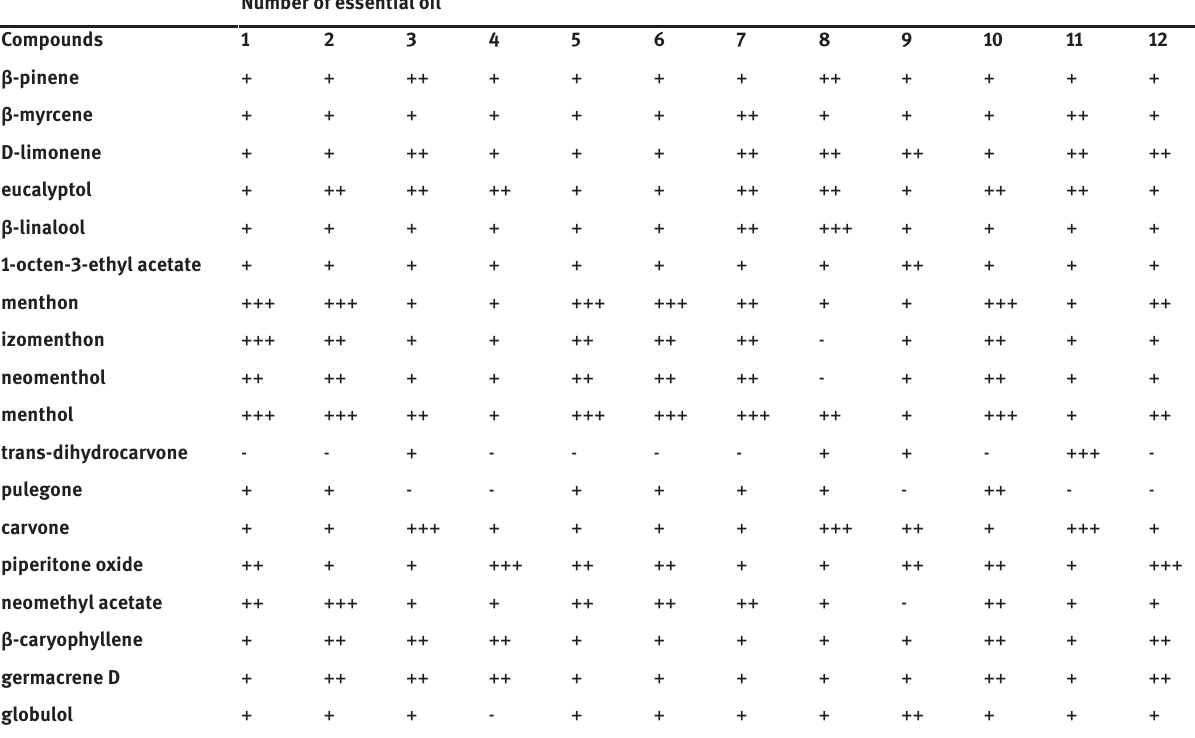
Table 3: The presence of the compounds (above 2%) and their relative concentrations. + below 2%, ++ 2-10%, +++ above 10%, - absence. Number of essential oil Compounds